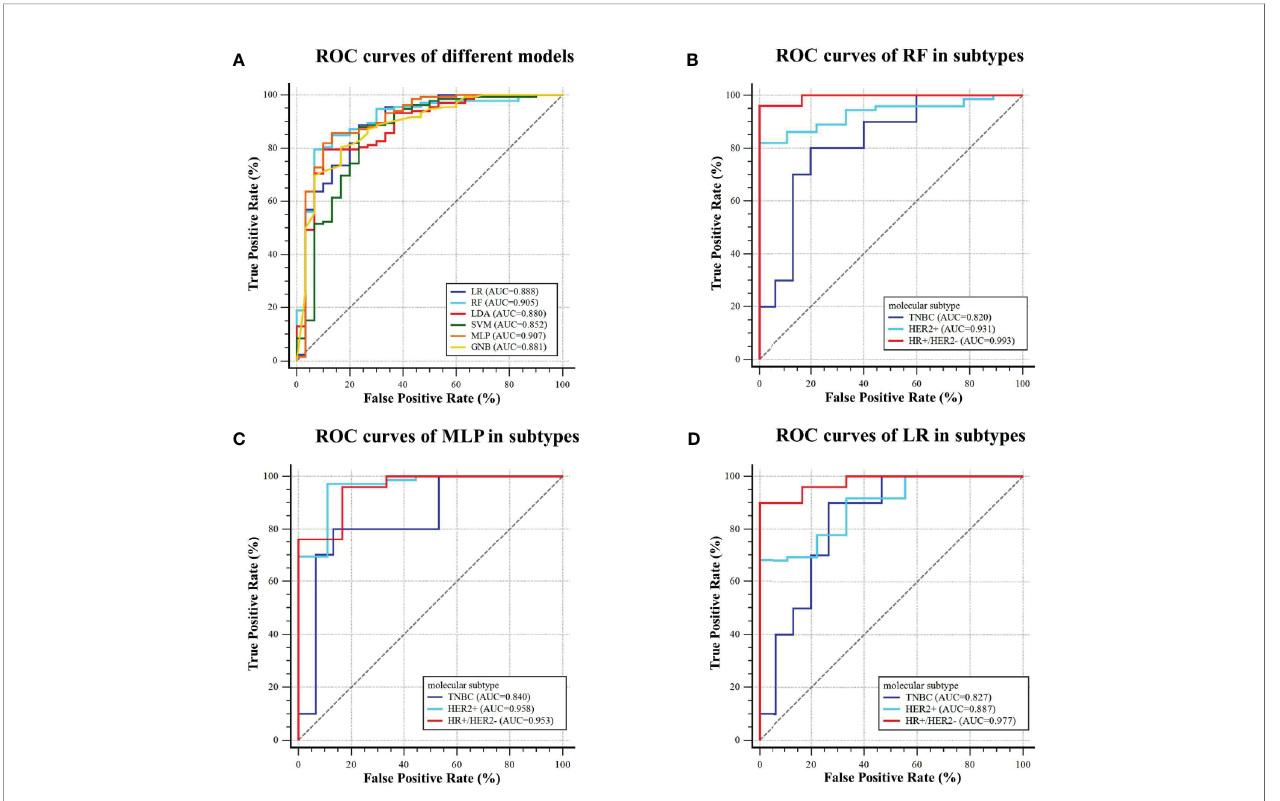
FIGURE 6 | ROC curves of the models predicting AR expression on the testing dataset. (A) Six machine learning classi fi ers were utilized for predictive model construction and their AUCs; (B – D) ROC curve of RF, MLP, and LR in three subtypes (TNBC, HER2+, and HR+/HER2 − ), respectively.